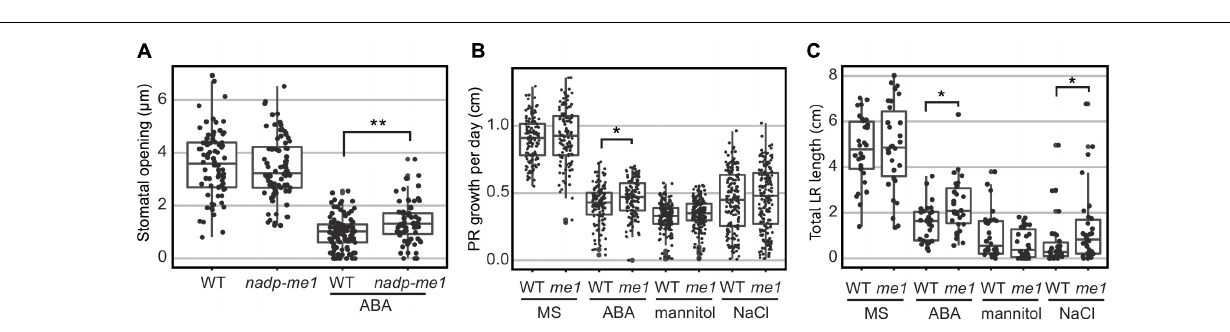
of germinated seeds are lower for both lines but nadp-me1 seeds reach 2.5–3 folds higher germination percentages than WT at 62 and 86 h ( Figure 3B ). Then, these results show that under both